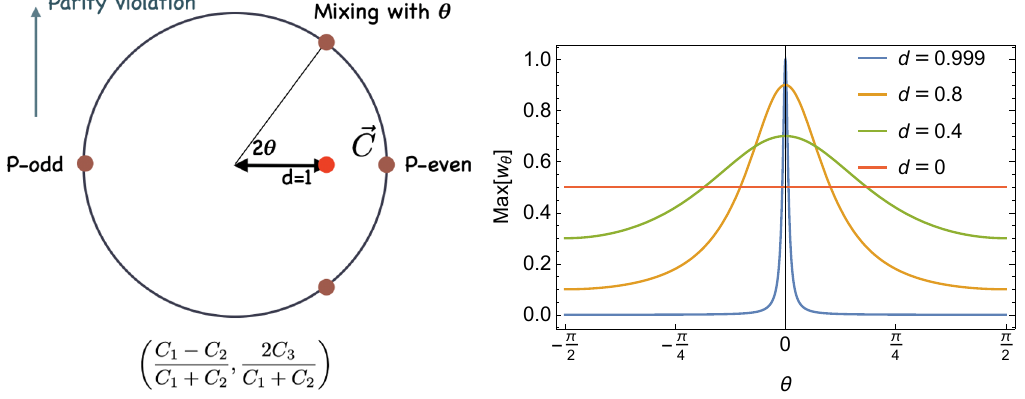
Figure 16. Left: a projection of the positivity cone in the space of ~C = ( C 1 , C 2 , C 3 ) onto the hyperplane C + C = 1 . The brown points correspond to generators with different mixing angles 1 2 θ . θ = 0 and θ = π correspond to purely P-even and P-odd couplings, both of which are parity conserving. Right: the upper bound on w of different θ values, for the point ~C = 1 θ shown as a red point on the left